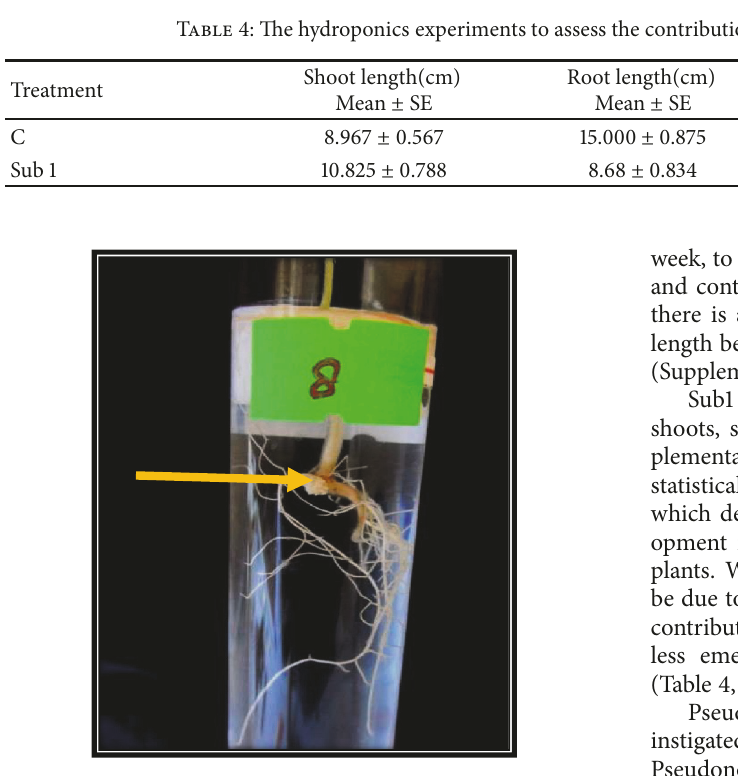
Figure 2: The formation of nodules by a replicate treated with Sub1 culture. The control plants are shown in Supplementary Figure 2. The nodule (the enlarged area in peach color) found at the helm of the roots is shown with an orange